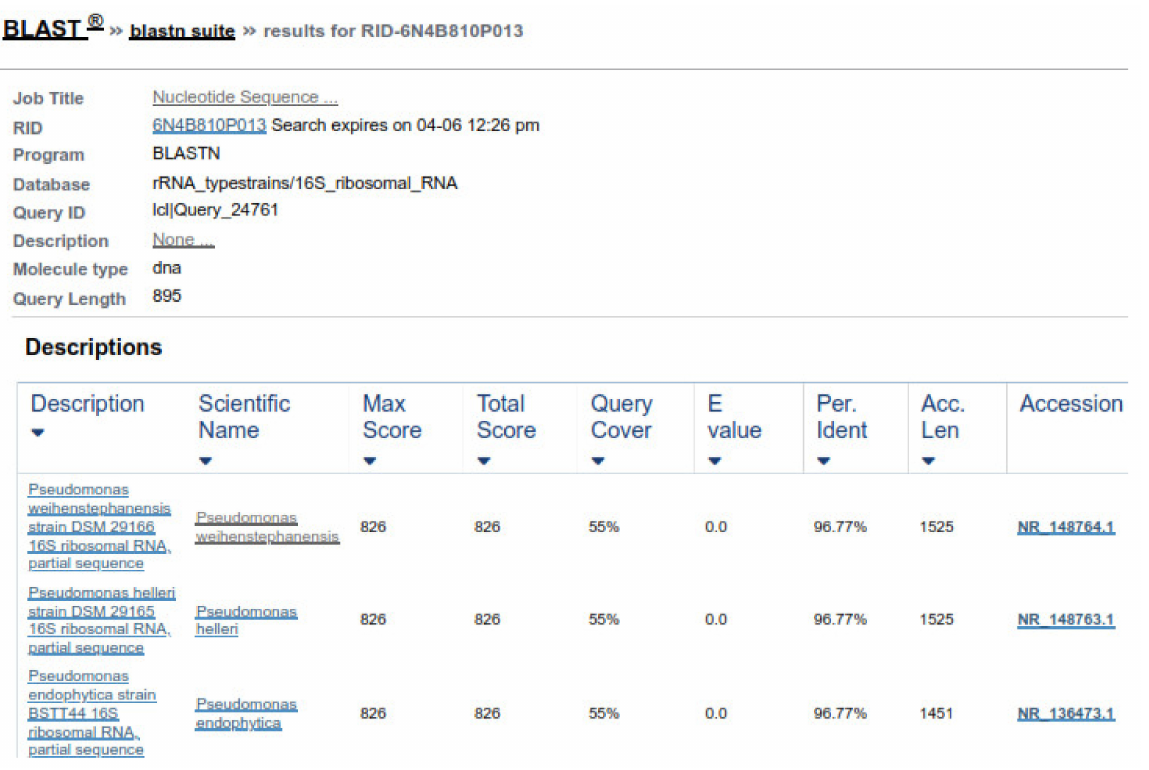
Figure 9. Sequence similarity of ABY with Comamonas jiangduensis